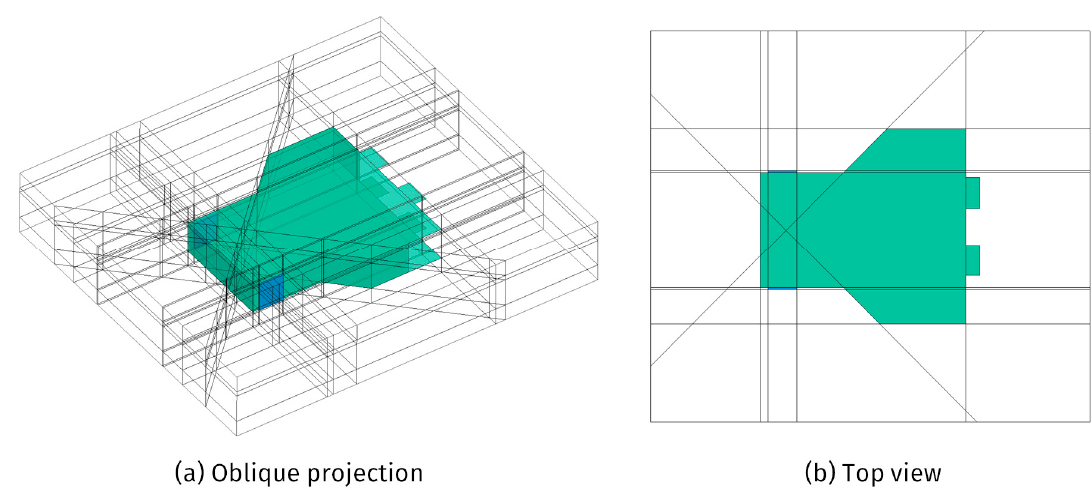
Appl. Sci. 2020 , 10 , x FOR PEER REVIEW Figure 4. Base solid split by each plane containing a major face. Figure 4. Base solid split by each plane containing a major face.